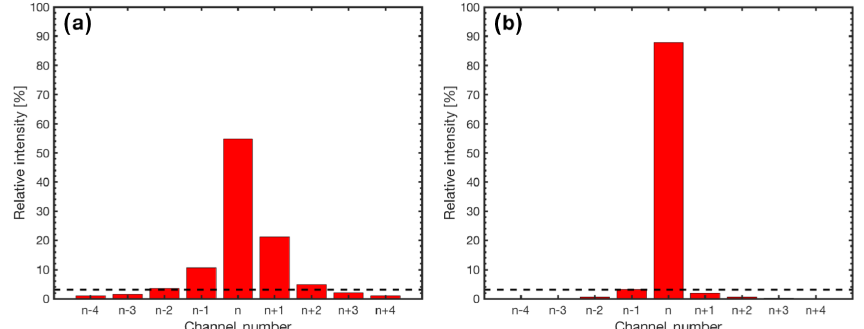
Figure 4. Characterization of the optical crosstalk between adjacent channels of the MAPMT with the old version (a) and the redesigned version of the fiber coupler (b) . Note that the manufacturer-specified electrical crosstalk level of 3% is indicated in the graphs. See text for further details.